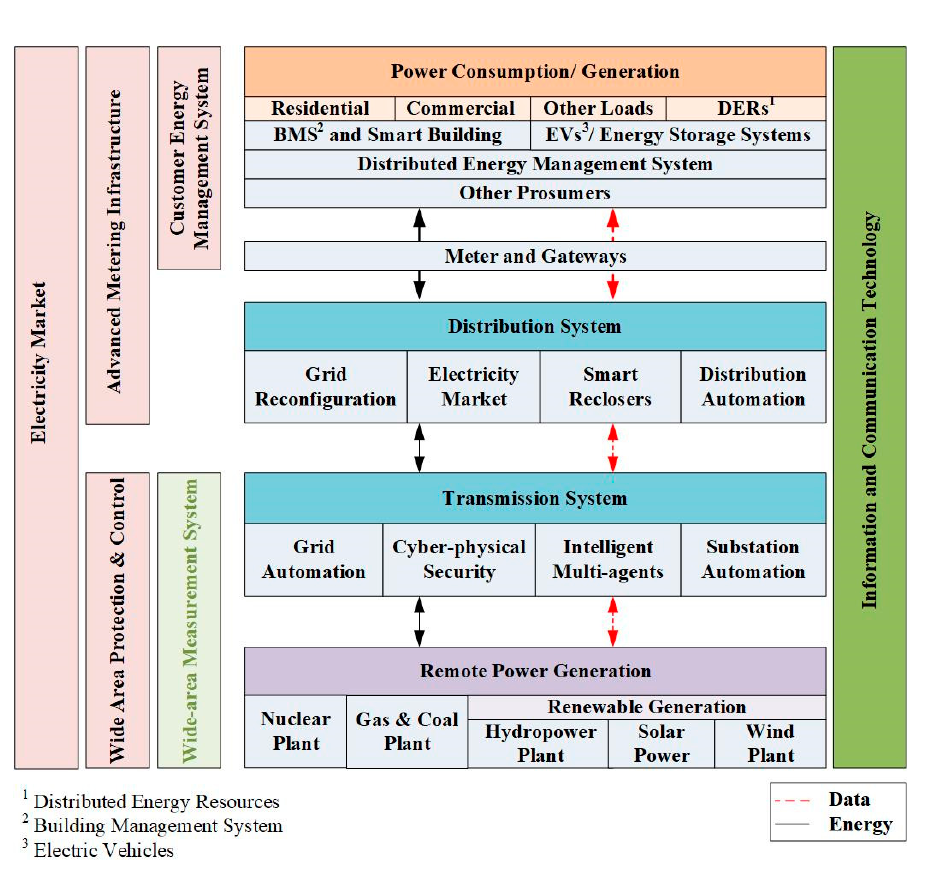
Figure 1. General outline of a Smart Grid.